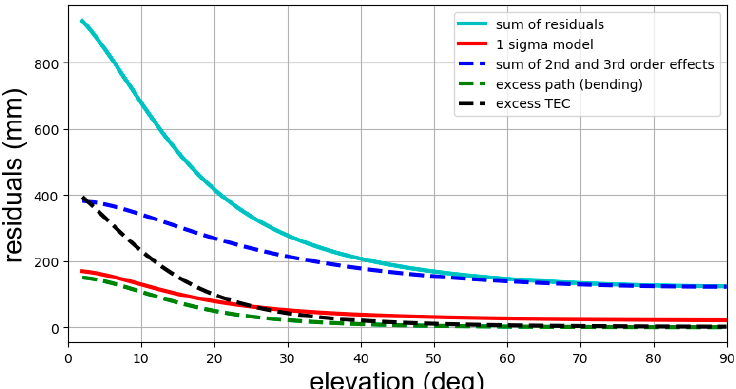
Figure 6. The overbounding model and its components. Sum of all residuals (cyan), the sum of second- and third-order effects (blue), the excess path (green), excess TEC (black), and the overbounding model (red). The underlying assumptions developed in the upper sections of this paper are: maximum TEC of 360 TECU, magnetic induction of 0.6G, single layer height of 350 km.